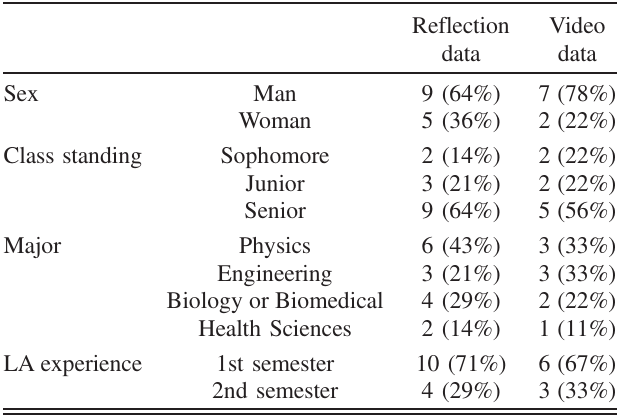
TABLE I. Participant demographics. N ¼ 14 students contrib- uted reflection data, and N ¼ 9 students contributed video data to the